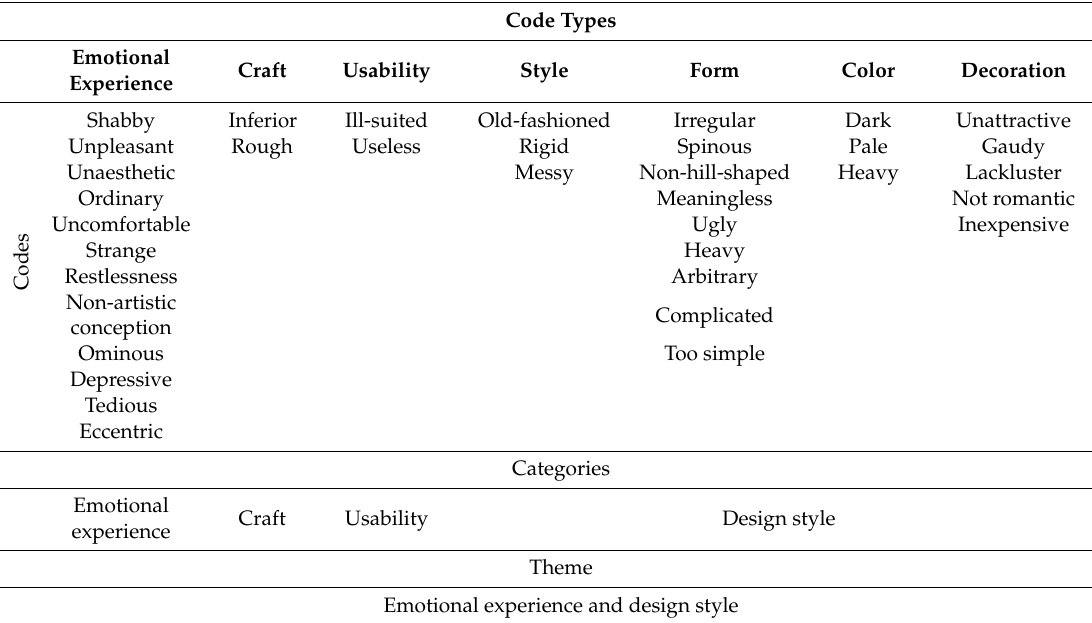
Table 5. The Codes, Categories, and Themes Associated with Unpleasant Features of the Hill